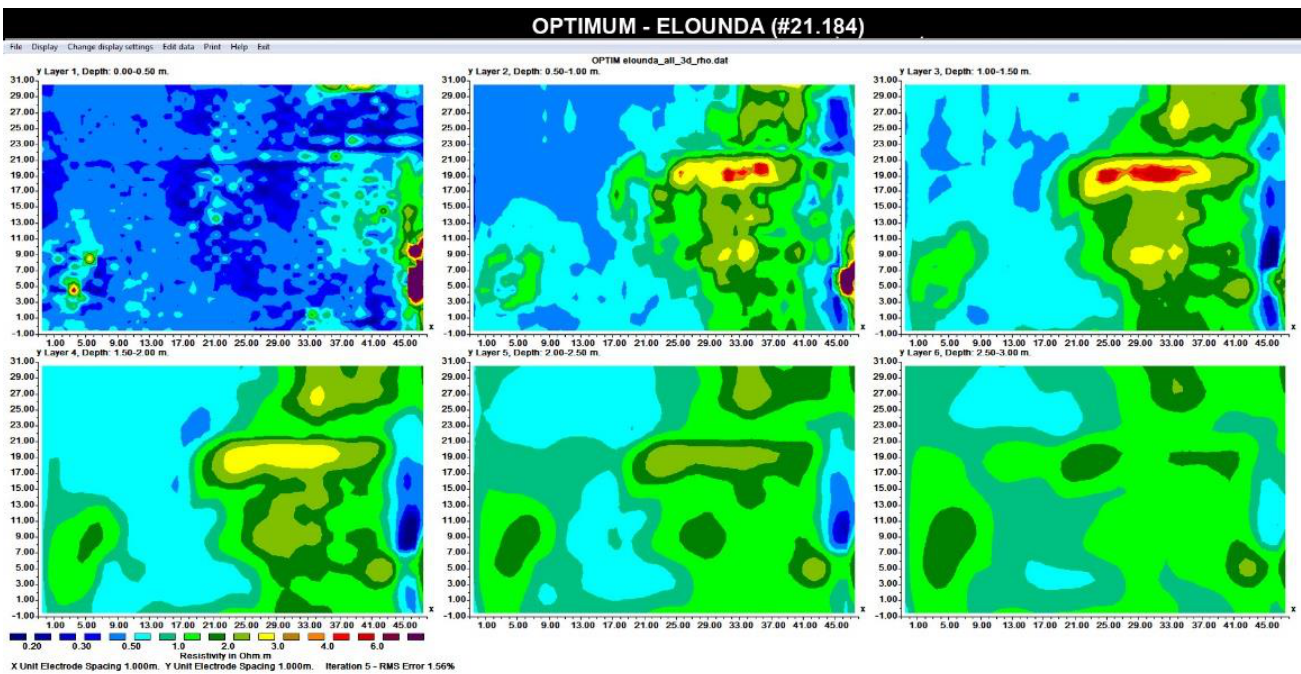
Figure 18. Inversion results from the Optimum Elounda field data set. Figure 19. Inversion results from the Optimum Elounda field data